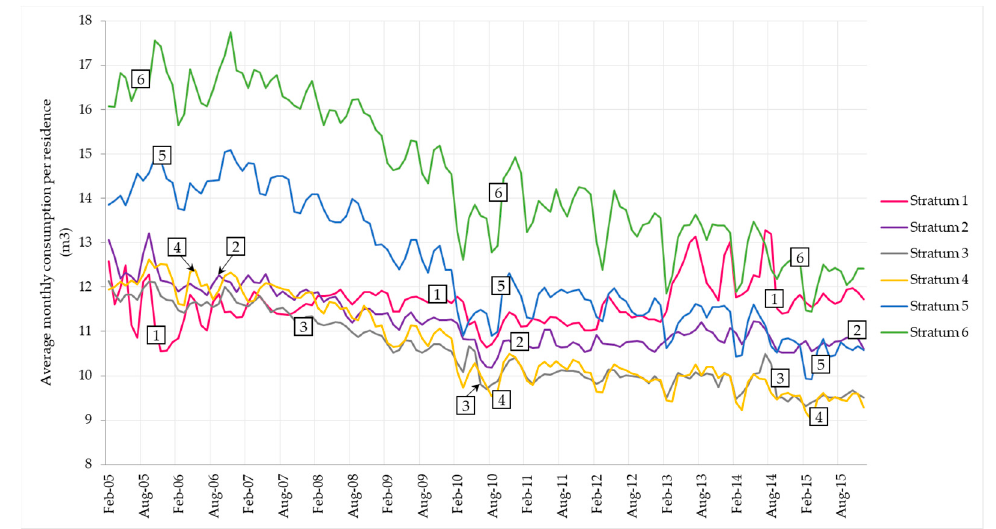
Figure 1. Average monthly consumption per stratum. Source: Authors’ elaboration based on data reported on Facilities Information System (http://www.sui.gov.co).